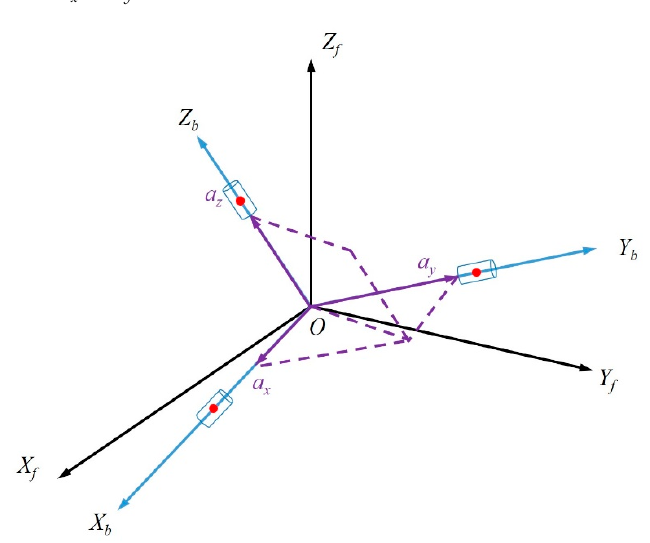
Figure 8. Installation deviation of SINS.